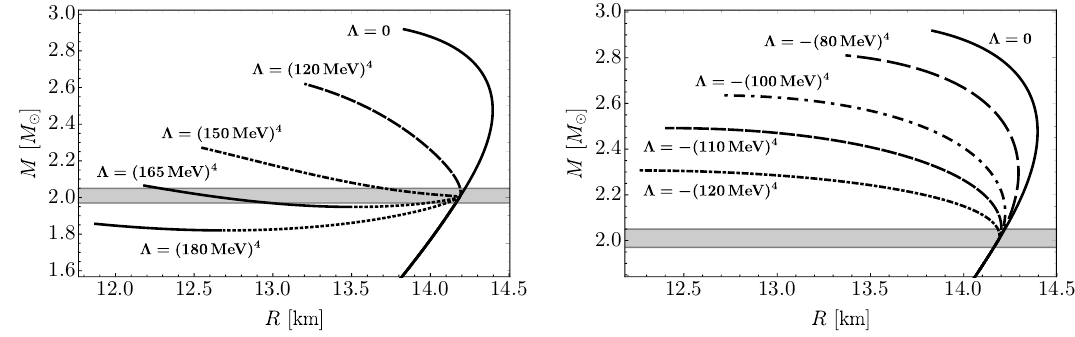
Figure 1. Mass versus radius curves corresponding to the sti(cid:11) parametrization of Hebeler et al. [30] with (cid:11) = 3. Dotted curves in the plot on the left correspond to unstable con(cid:12)gurations violating eq. (4.2). Positive values of (cid:3) are shown in the plot on the left, and negative ones on the right.